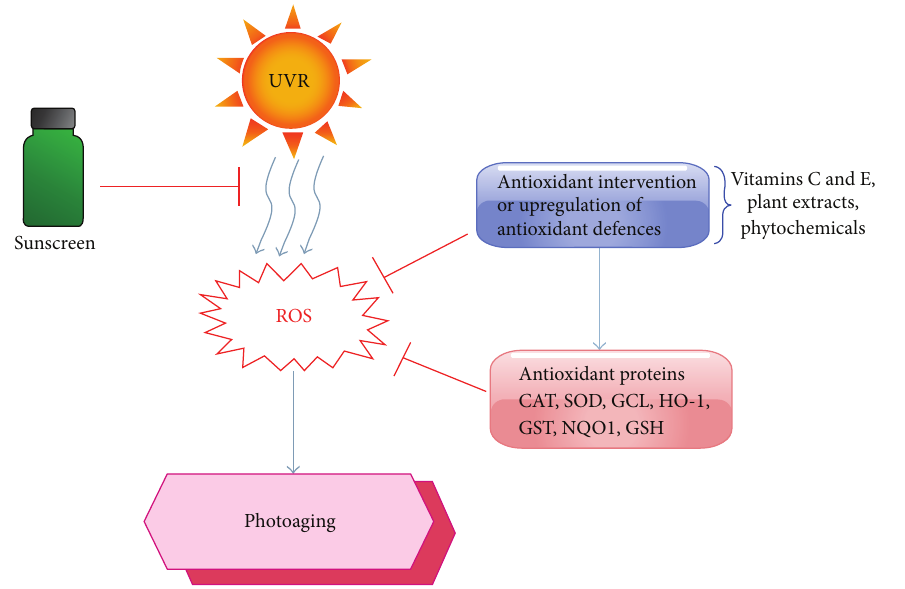
Figure 2: Anti-ROS as a potential anti-skin aging intervention. Possible interventions that delay ESC DNA damage, by preventing UVR exposure using sunscreen, anti-ROS, or upregulation of antioxidant